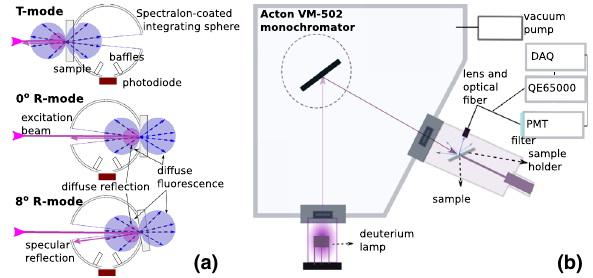
Fig. 2 a IS configurations. T-mode: excitation wavelength is fully blocked by the substrate, only fluorescence emitted forward is regis- tered. 0 ◦ R-mode: specular reflection of the incident beam escapes the IS, the diffuse reflection and fluorescence emitted back are registered. 8 ◦ R-mode: specular and diffuse reflection of the incident beam and the fluorescence emitted back are registered. b Schematic of the fixed angle VUV measurement setup. Its photon detector is either a PMT